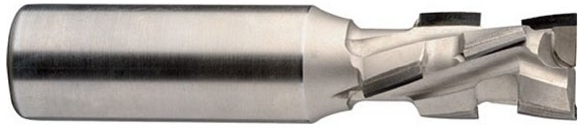
Figure 2. Diamond shank-type cutter IGM Fachmann Ekonomik Z2+1. Parameters of milling process: